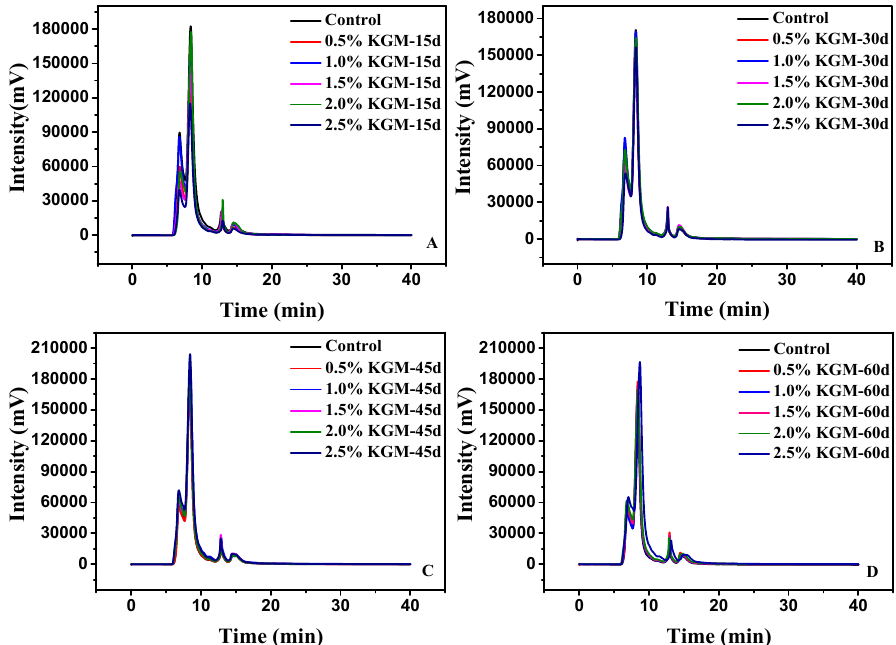
Figure 1. Size-exclusion HPLC chromatogram of gluten proteins in frozen dough with di ff erent proportions of KGM added. 15 days frozen storage ( A ), 30 days frozen storage ( B ), 45 days frozen storage ( C ), and 60 days frozen storage ( D ). Table 1. E ff ect of di ff erent proportions of KGM added to the molecular weight of frozen